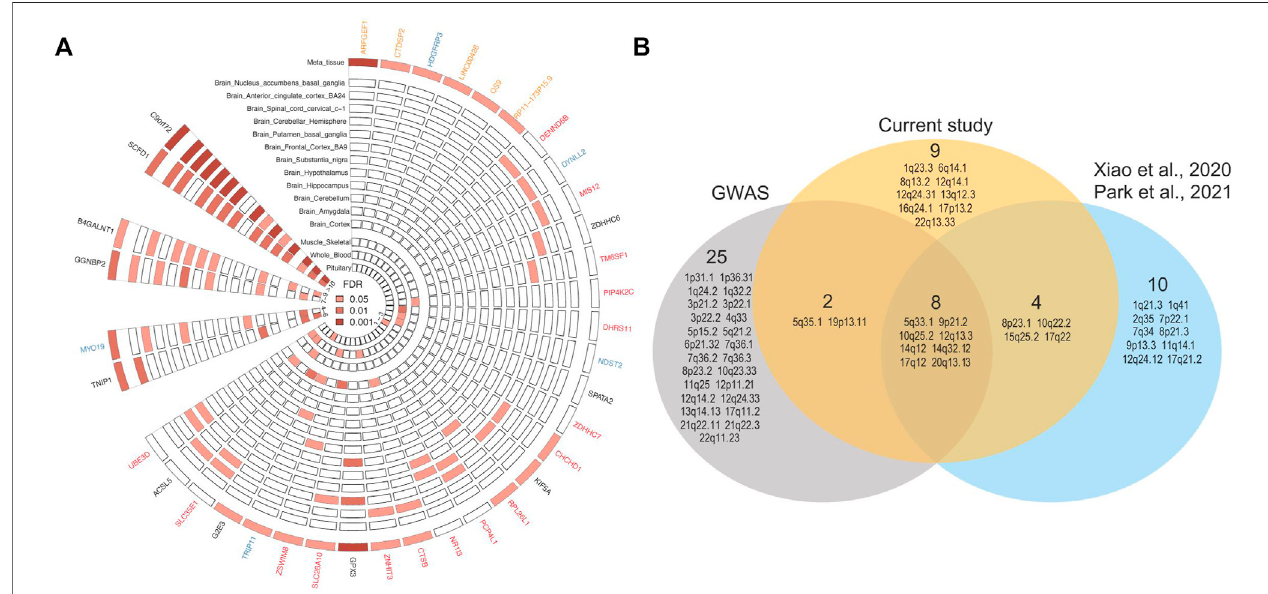
FIGURE 2 | Identi fi cation of genes associated with ALS by TWAS analysis and comparison with other studies. (A) Genes associated with ALS were identi fi ed by S-PredictXcan and S-MetaXcan across tissues (FDR < 0.05). Meta_tissue represented the joint effect of gene expression from different tissues using S-MetaXcan. The circlesrepresenteddifferenttissuesfromoutsidetoinside,wherethebraintissueswereclusteredtogether,whileeachsectorexpressedadifferentgene.Thestrengthof color of each cell indicated the signi fi cance of the association of genes (sectors) with ALS in different tissues (circles). Among these genes, red and orange, respectively, indicate genes newly discovered from S-PrediXcan and S-MultiXcan, blue indicates the fi ve replicated TWAS-discovered genes recently, and black indicates genes previously reported by GWAS. Brain tissues are grouped, and grouped genes with similar TWAS patterns are shown (the number of signi fi cant signals labeled in the innermost ring). (B) Venn diagram displayed loci identi fi ed in different studies. The gray circle represents published GWASs, the blue circle represents two recentTWASsfromXiaoetal.(2020)andParketal.(2021),andtheorangecirclerepresentsourcurrentTWAS.Thenumberrepresentsthenumberoflociineachregion.